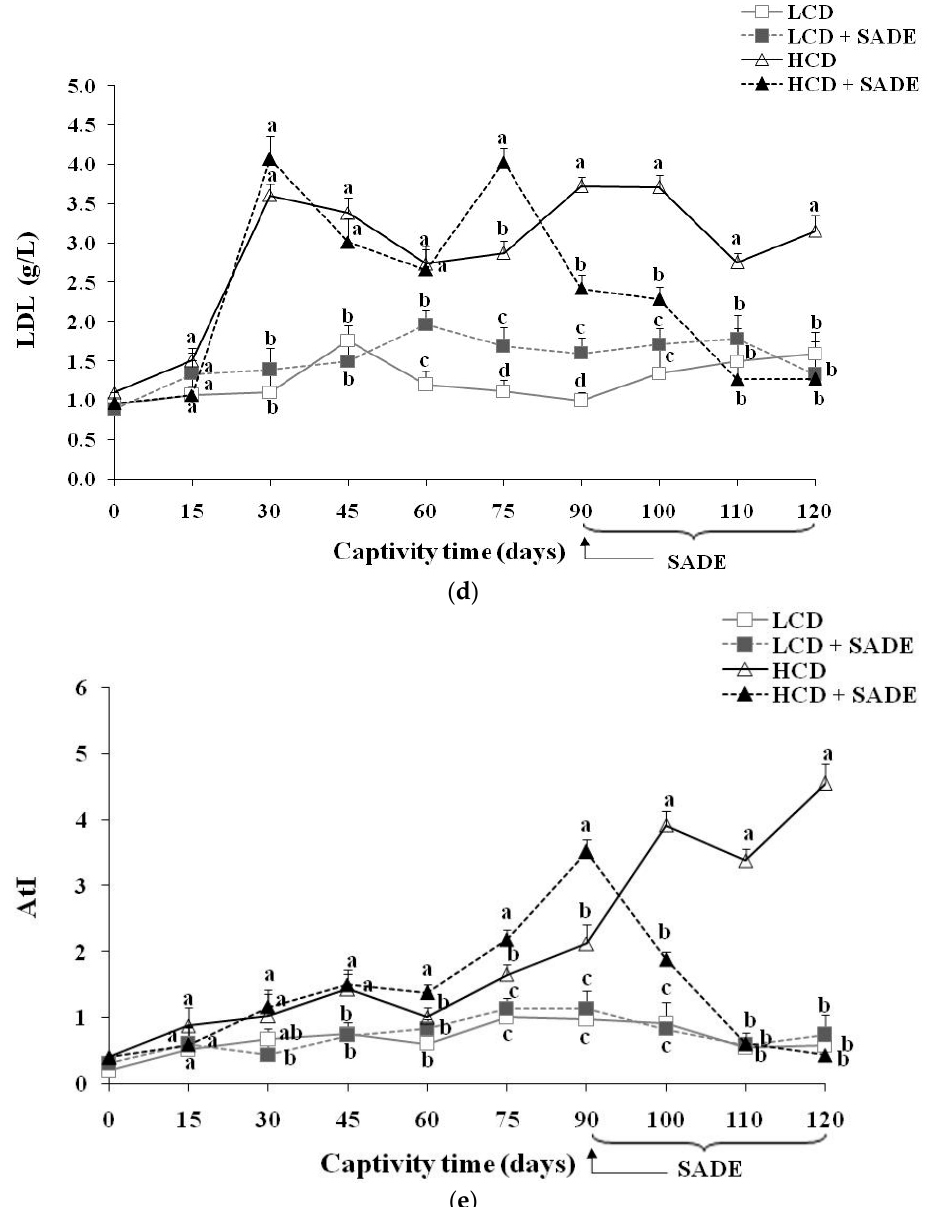
Figure 5. ( a ) Total cholesterol (TC) (g/L) in P. obesus . LCD: animals group fed with natural low- calorie vegetable diet, LCD + SADE: LCD treated with S. arabica decocted, HCD: rats fed with high-calorie diet and HCD + SADE: rats fed with high-calorie diet treated with S. arabica decocted extract. ( b ) Triglycerides (TG) (g/L) in P. obesus . LCD: animals group fed with natural low-calorie vegetable diet, LCD + SADE: control treated with S. arabica decocted, HCD: rats fed with high-calorie diet and HCD + SADE: rats fed with high-calorie diet treated with S. arabica decocted extract. ( c ) HDL (g/L) in P. obesus . LCD: animals group fed with natural low-calorie vegetable diet, LCD + SADE: LCD group treated with S. Arabica decocted, HCD: rats fed with high-calorie diet and HCD + SADE: rats fed with high-calorie diet treated with S. arabica decocted extract. ( d ) LDL (g/L) in P. obesus . LCD: animals group fed with natural low-calorie vegetable diet, LCD + SADE: LCD treated with S. arabica decocted, HCD: rats fed with high-calorie diet and HCD + SADE: rats fed with high-calorie diet treated with S. arabica decocted extract. ( e ) Atherogenic index (AtI) in P. obesus . LCD: animals group fed with natural low-calorie vegetable diet, LCD + SADE: LCD group treated with S. arabica decocted extract, HCD: rats fed with high-calorie diet and HCD + SADE: rats fed with high-calorie diet treated with S. arabica decocted extract. Results are presented as means ± SD for ten rats in